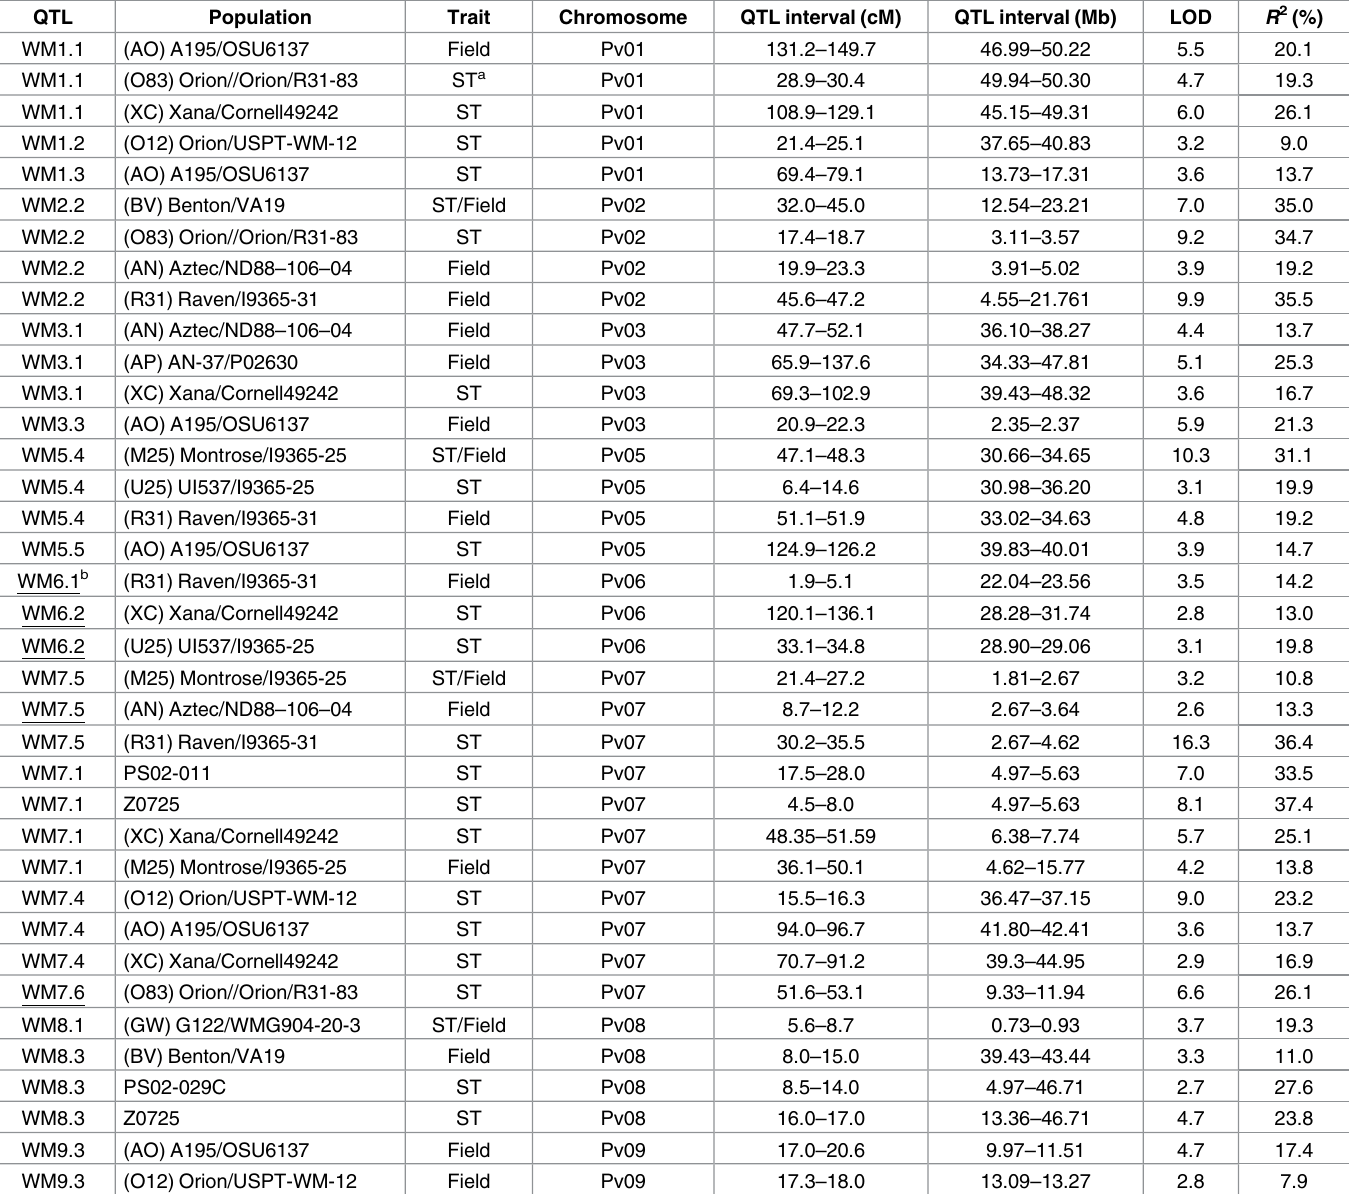
Table 2. Individual QTL for resistance to white mold in common bean identified across 14 RIL